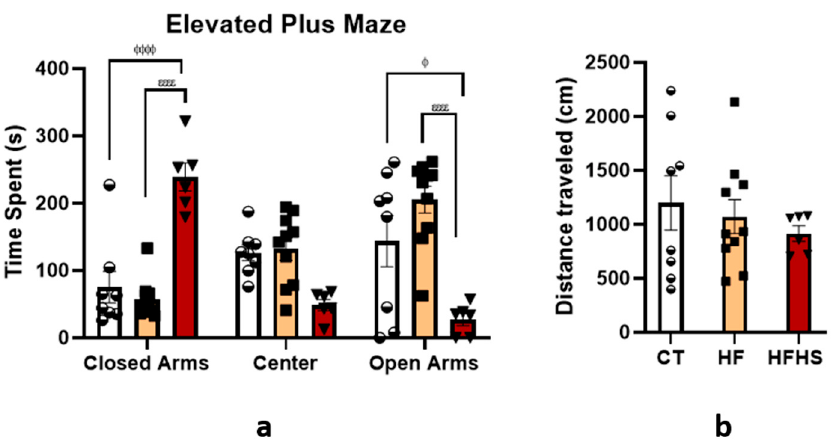
Figure 9. Elevated plus maze. The HFHS rats exhibited increased levels of anxiety. Histograms show the mean ± SEM time spent ( a ) in the arms and central square of the elevated plus maze and the total distance traveled during acquisition ( b ). HFHS rats spent more time in the closed arms of the maze compared to controls and HF rats. In agreement with this, they spent less time in the open arms of the maze compared to controls and HF rats. Furthermore, there were no significant differences in the distance traveled or time spent in the central square of the elevated plus maze between the three groups. No differences were found in the total distance traveled during acquisition. φ p < 0.05; φφφφ p < 0.0001 HFHS versus control; εεεε p < 0.0001 HFHS versus HF rats. The bars in white represent the mean for the control group, the bars in orange represent the mean for the HF group, and the bars in red represent the mean for the HFHS group. The circle represents the value for each animal in the control group, the square represents the value for each animal in the HF group, and the inverted triangle represents the value for each animal in the HFHS